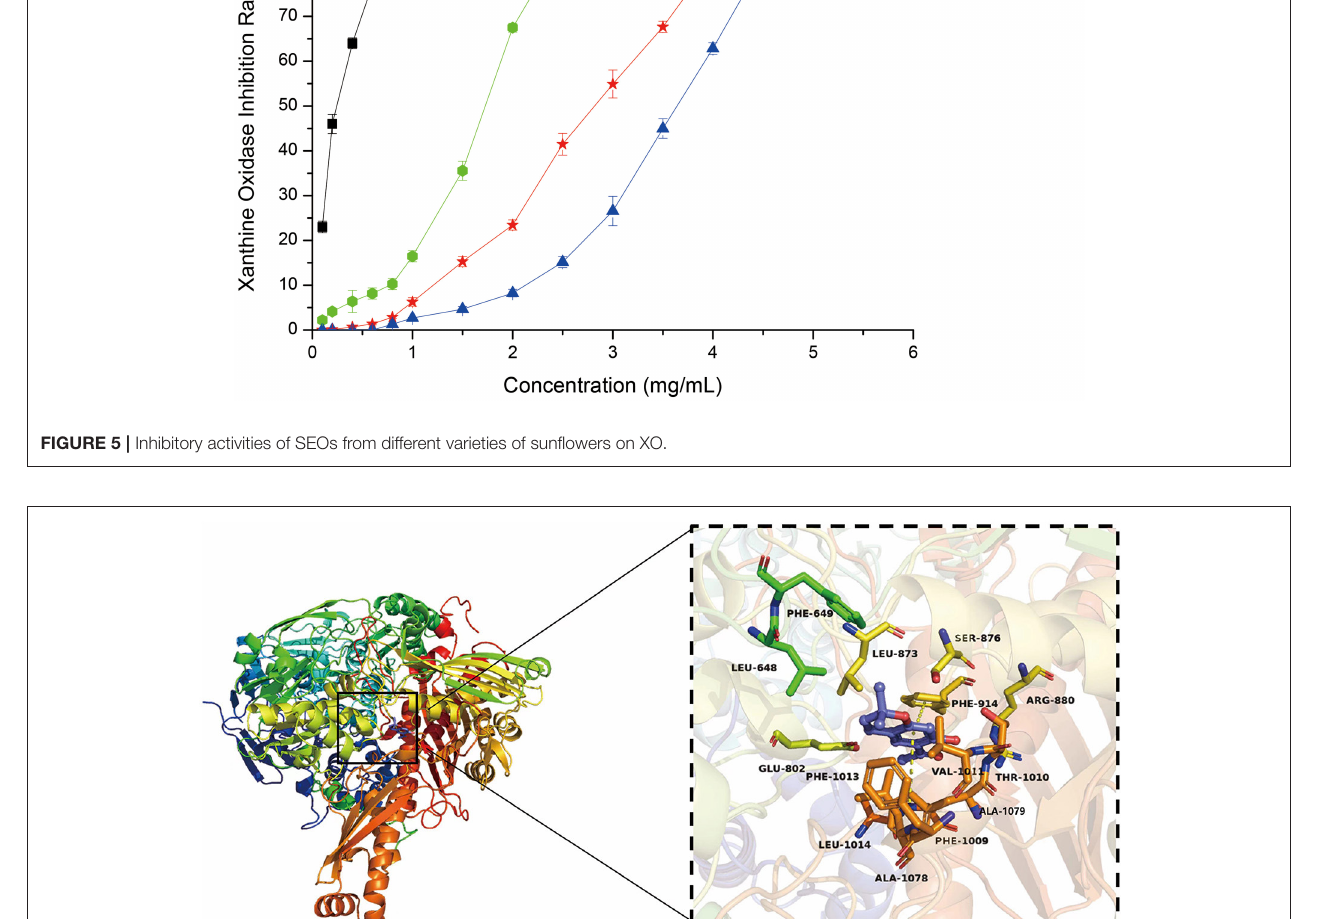
FIGURE 6 | Three-dimensional (3D) structure of XO and the active residues of XO binding to